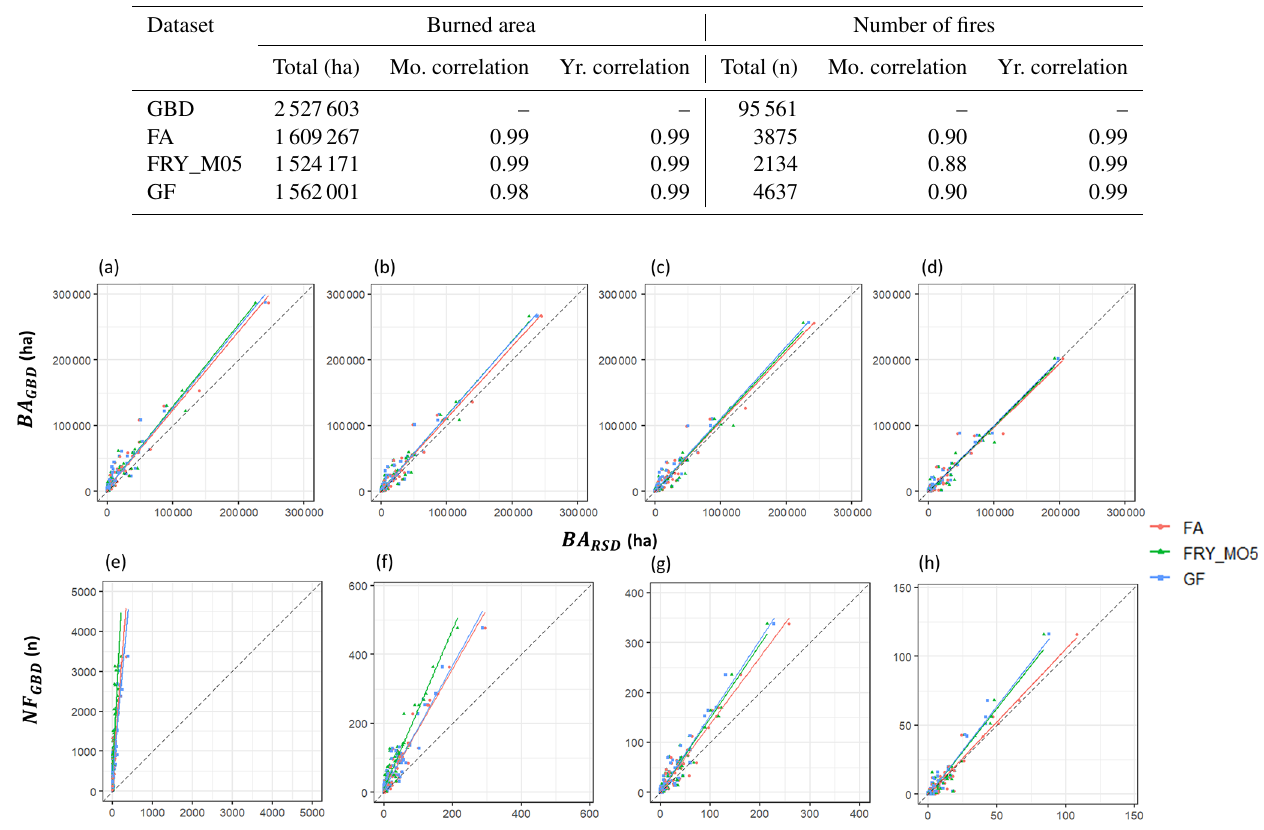
Table 3. Correlation between RSDs and the GBD of monthly and annual burned area and number of fires for all fires ( > 1ha) between 2005 and 2015.